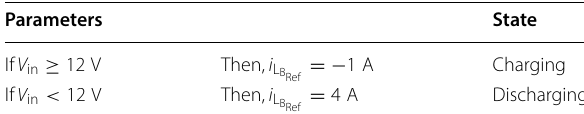
Table 1 The assumed values to define the systems point of operation (1)